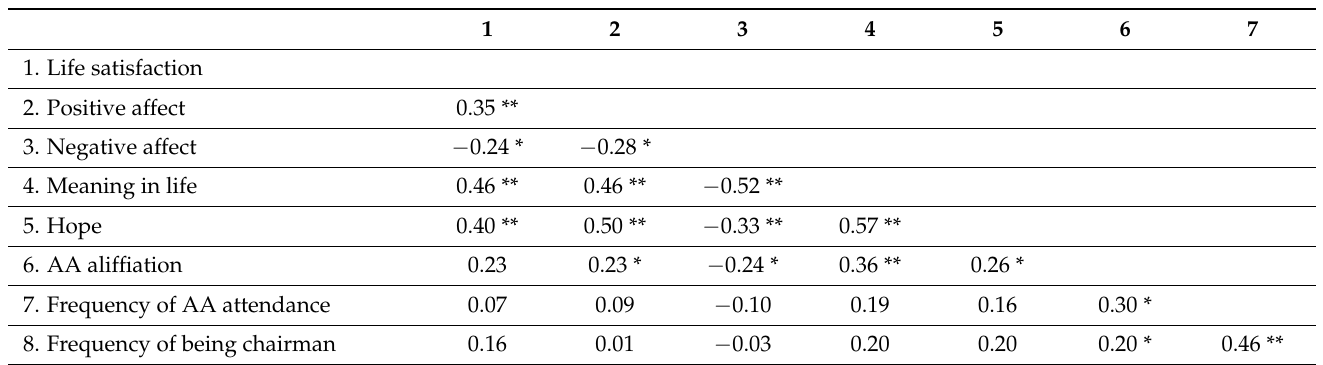
Table 3. Correlation matrix ( n = 70).